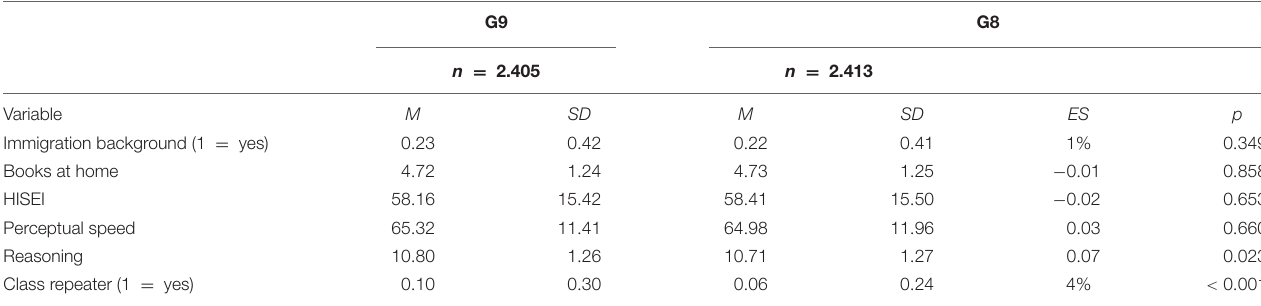
TABLE 1 | Descriptive statistics on central covariates before and after the